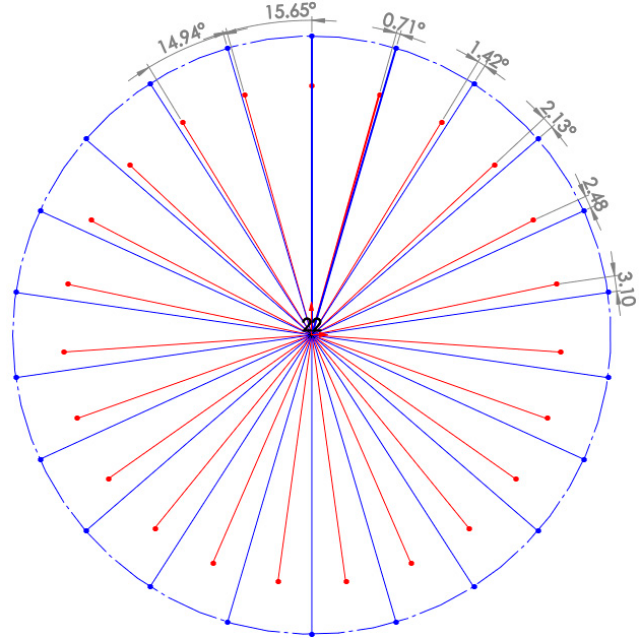
Figure 17. The phase difference of the 1st stage stationary blade and moving blade.